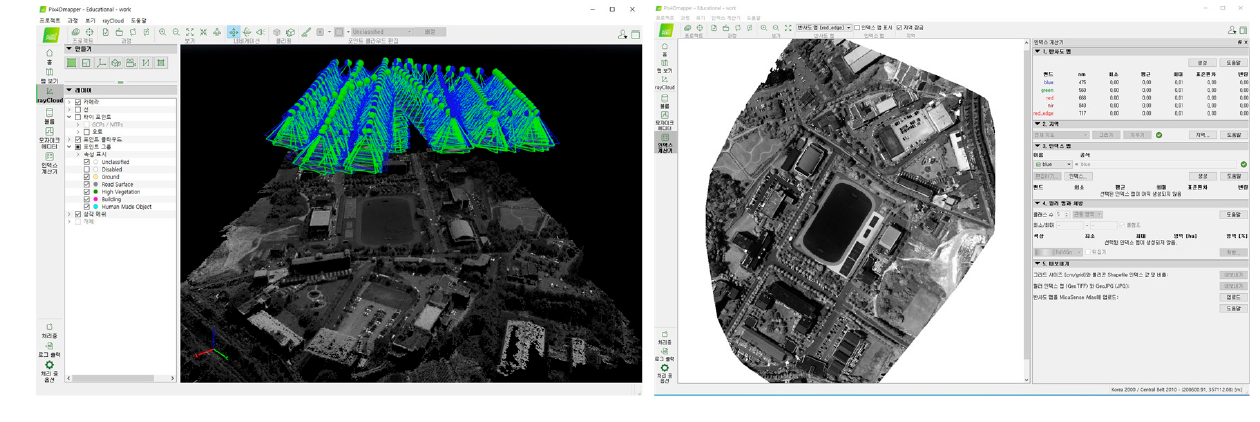
Figure 5. UAV image processing using Pix4D Mapper S/W.